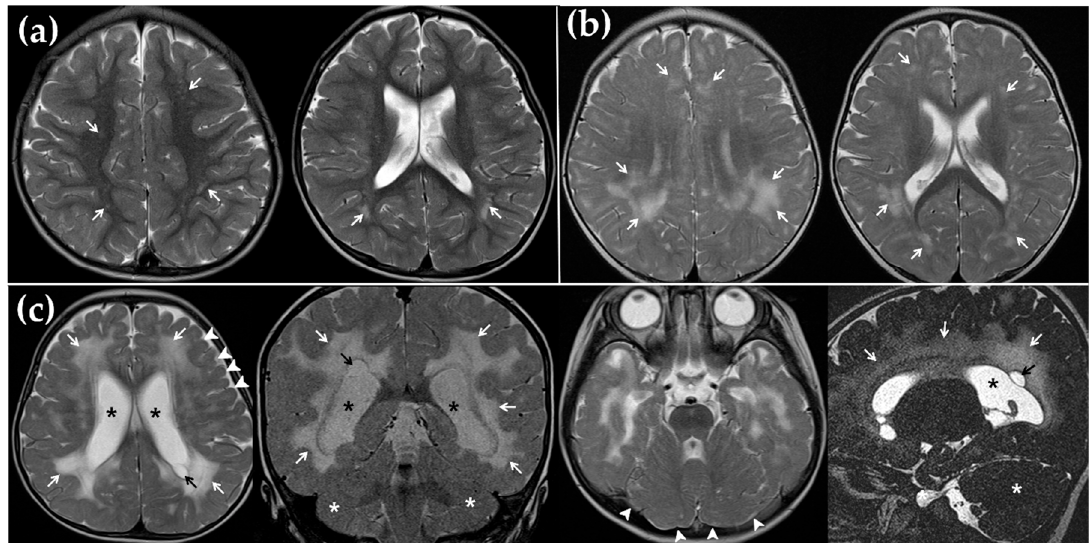
Figure. 1. Various features of T2-weighted MR images in patients with cytomegalovirus infection. ( a ) Multifocal white matter (WM) lesions (white arrows) in deep WM of frontal and parietal lobe (CH-4). ( b ) Extensive WM lesions (white arrows) in periventricular and deep WM of whole brain areas (CH-9). ( c ) Diffuse WM lesion (white arrows) combined with periventricular cyst (black arrow), ventriculomegaly (black asterisk), cerebellar hypoplasia (white asterisk), and polymicrogyria (white arrowhead) (CH-3). Table 2. The outcome comparison of cochlear implantation according to the findings of MRI abnormalities.